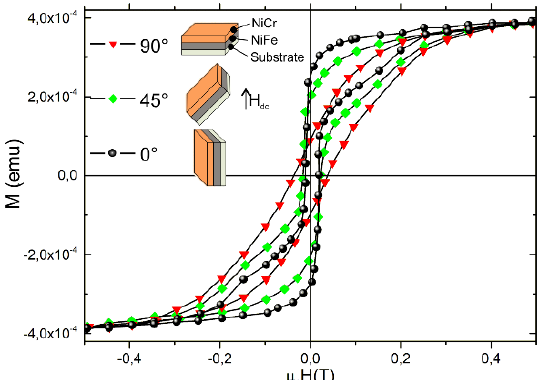
Figure 4. Hysteresis loops obtained at T = 2 K for sample oriented at 0°, 45°, and 90° in respect of the direction of external magnetic field. Reprinted with permission from [46], published by John Wiley & Sons, 2017.